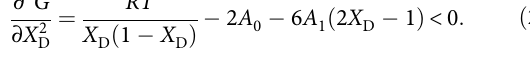
Fig. 6 3D morphology and layered structure of spicules. Nano-HT reconstructed parallel section ( a ) and horizontal section ( b ) of the brittle star spicule (pixel size is 120 nm)